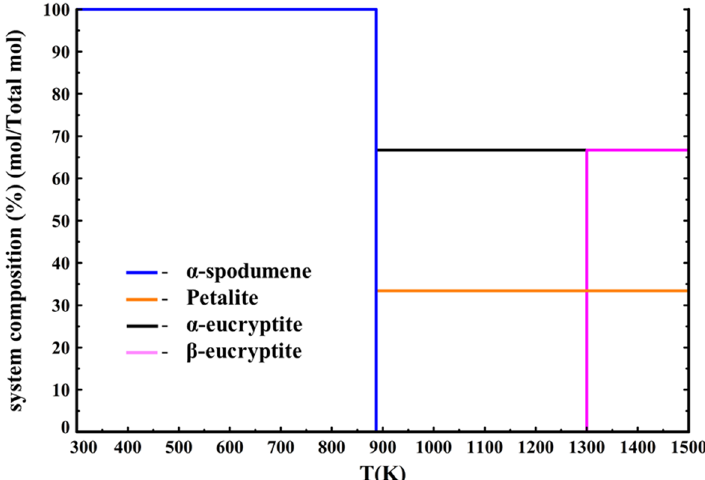
Figure 10. Phase diagram of spodumene using data from Konar [15] for α -spodumene and β - spodumene, and Barin’s [33] data for the other species considered in the four-element system (Li + Al + 2 Si + 3 O 2